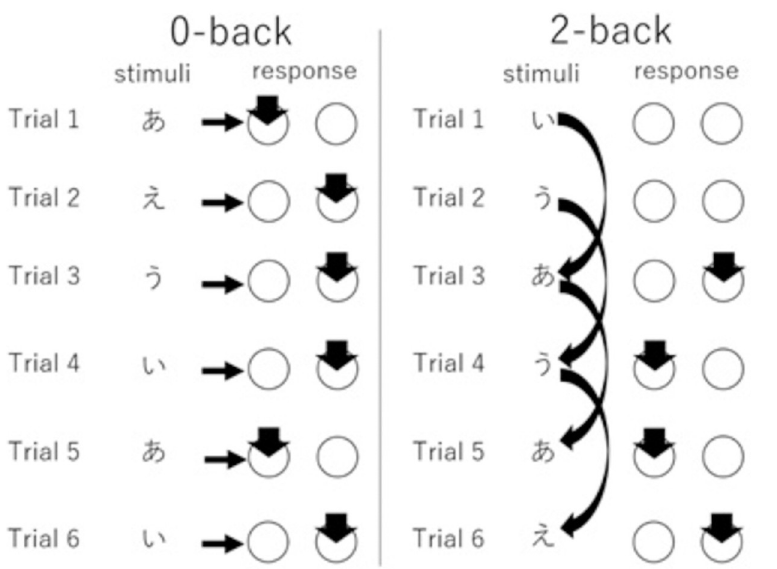
Fig 1. A schematic diagram of the procedures used for the N-back